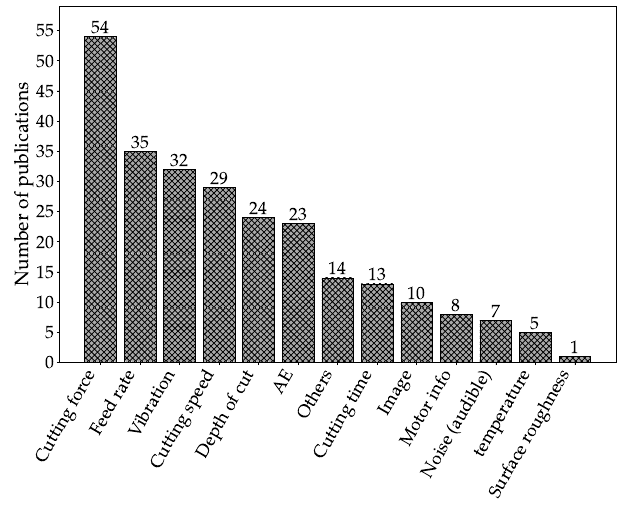
Figure 22. Input variables of all the